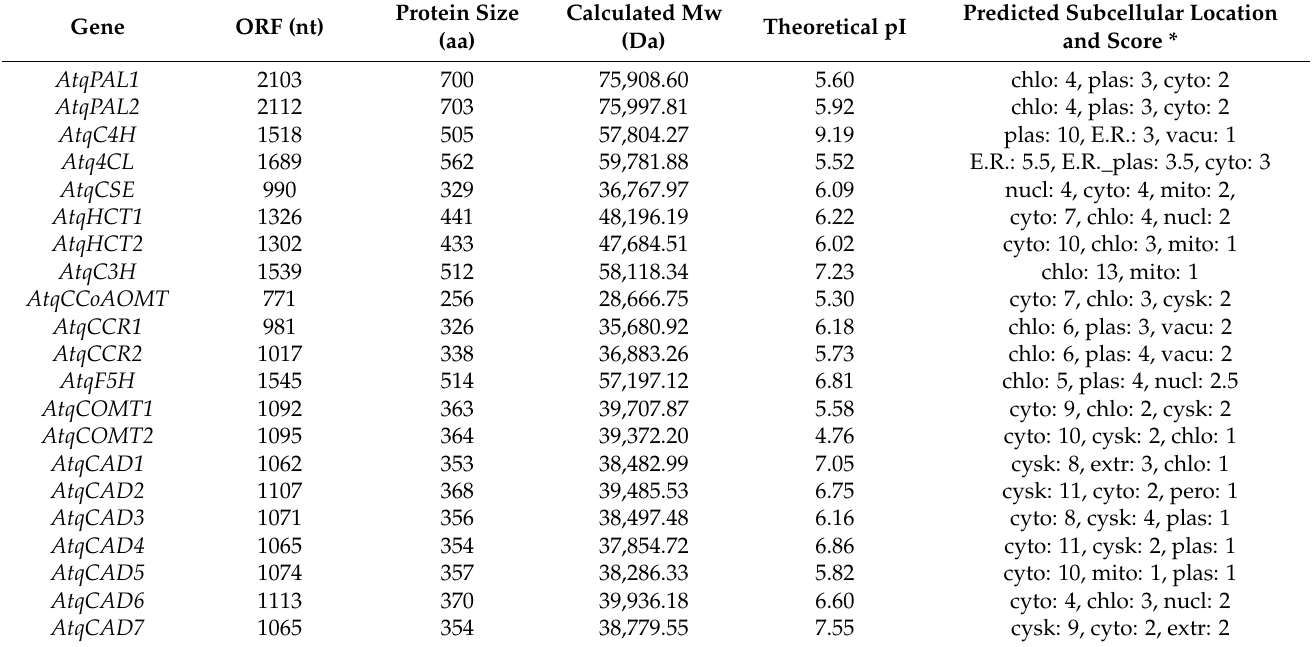
Table 2. Detailed sequence information of genes involved in lignin biosynthesis in Agave tequilana